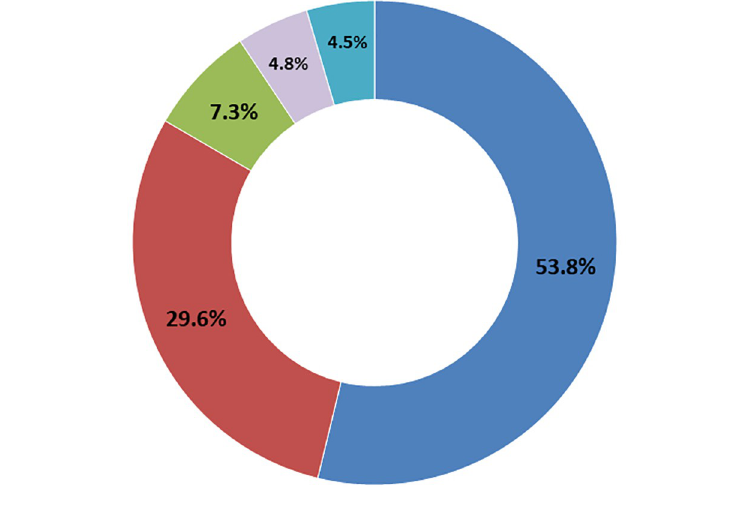
Fig 2. The proportion of mixed infection with blood parasites among positive blood smears.